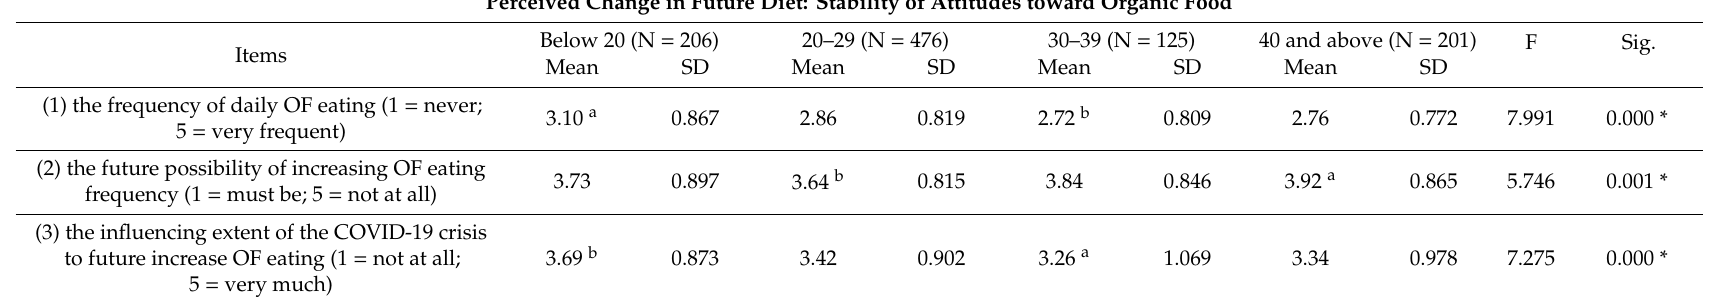
Table 4. The means, standard deviations, and F-tests of di ff erences of the measurement “perceived change in future diet: stability of attitudes toward organic food” across